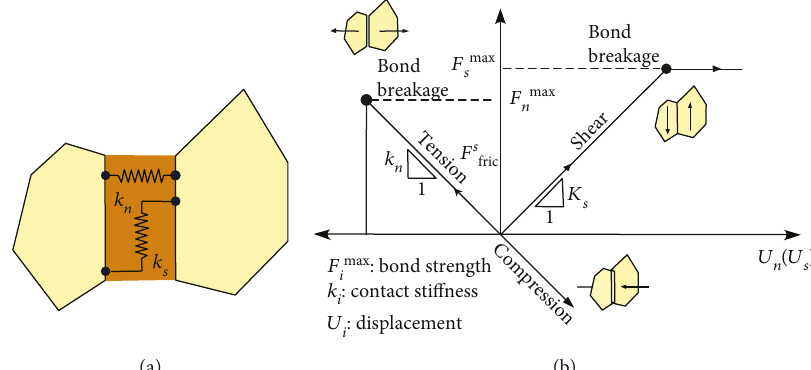
Figure 6: Constitutive model of the contact in UDEC: (a) normal and shear sti ff ness between blocks; (b) constitutive behavior in shear and tension ( i = s , n ) [34].